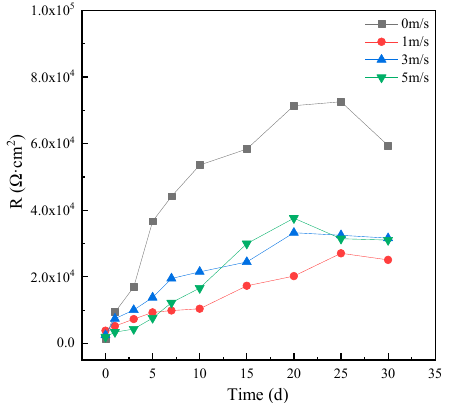
Figure 6. Corrosion resistance of MZ in different flowing seawater varying with time.